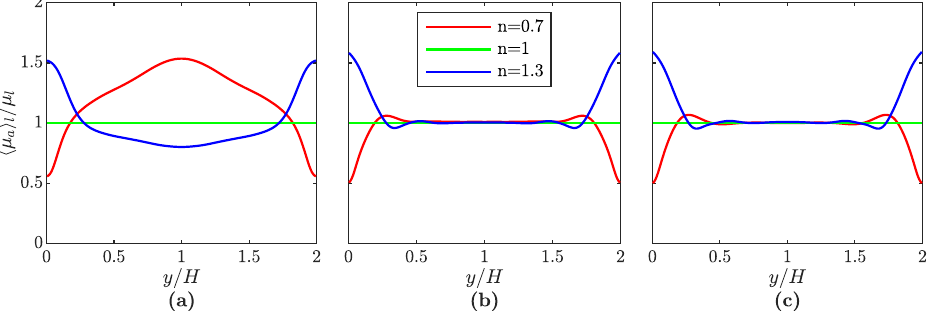
Figure 5. Average apparent dynamic viscosity of the liquid phase (cid:104) µ a (cid:105) l , normalized by the dynamic viscosity of the Newtonian fluid µ l , as a function of the wall-normal coordinate for the single-phase ( a ) and the two-phase setups with Eo = 0.3125 ( b ) and Eo = 3.75 ( c ).